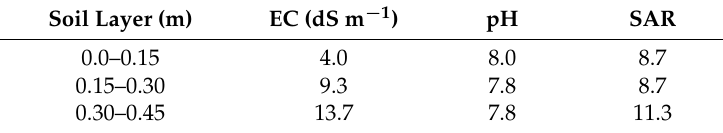
Table 2. Chemical characteristics of topsoil at the study site.